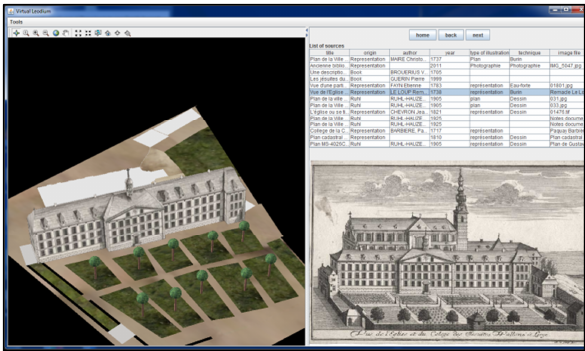
Figure 5. Remacle Le Loup’s version of a building facade is displayed in place of Ruhl’s